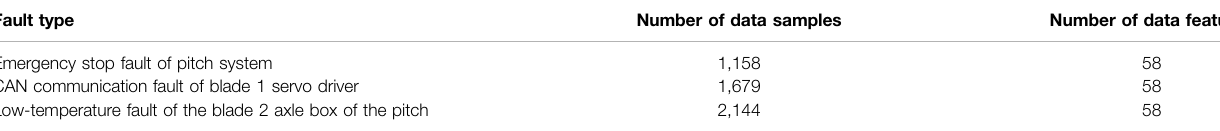
TABLE 1 | Data structures of three faults of pitch